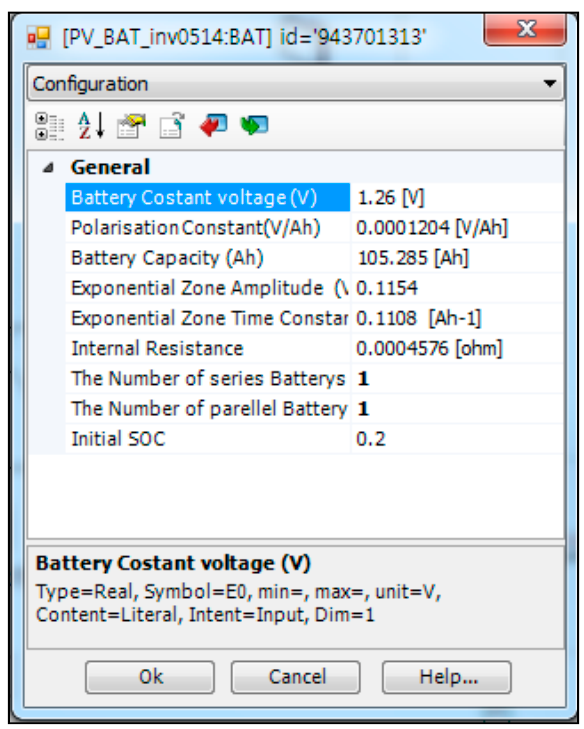
Figure 16. Battery parameter input window.